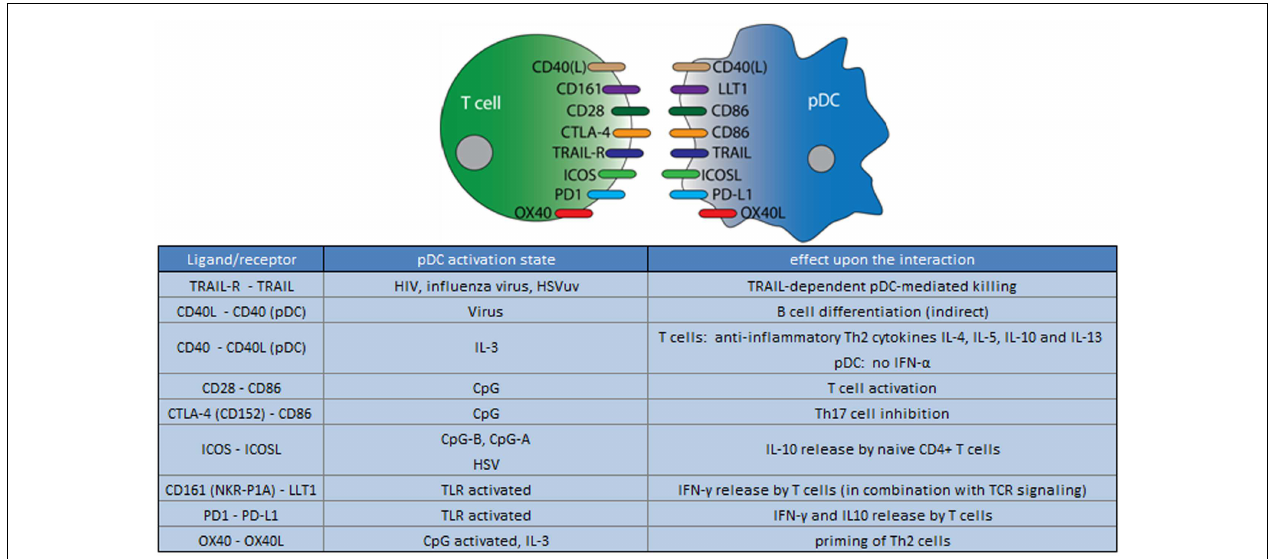
FIGURE 3 | Ligand/receptor paring of a pDC with aT cell and the maturation state/activation stimuli associated with ligand or receptor expression on the pDC surface .